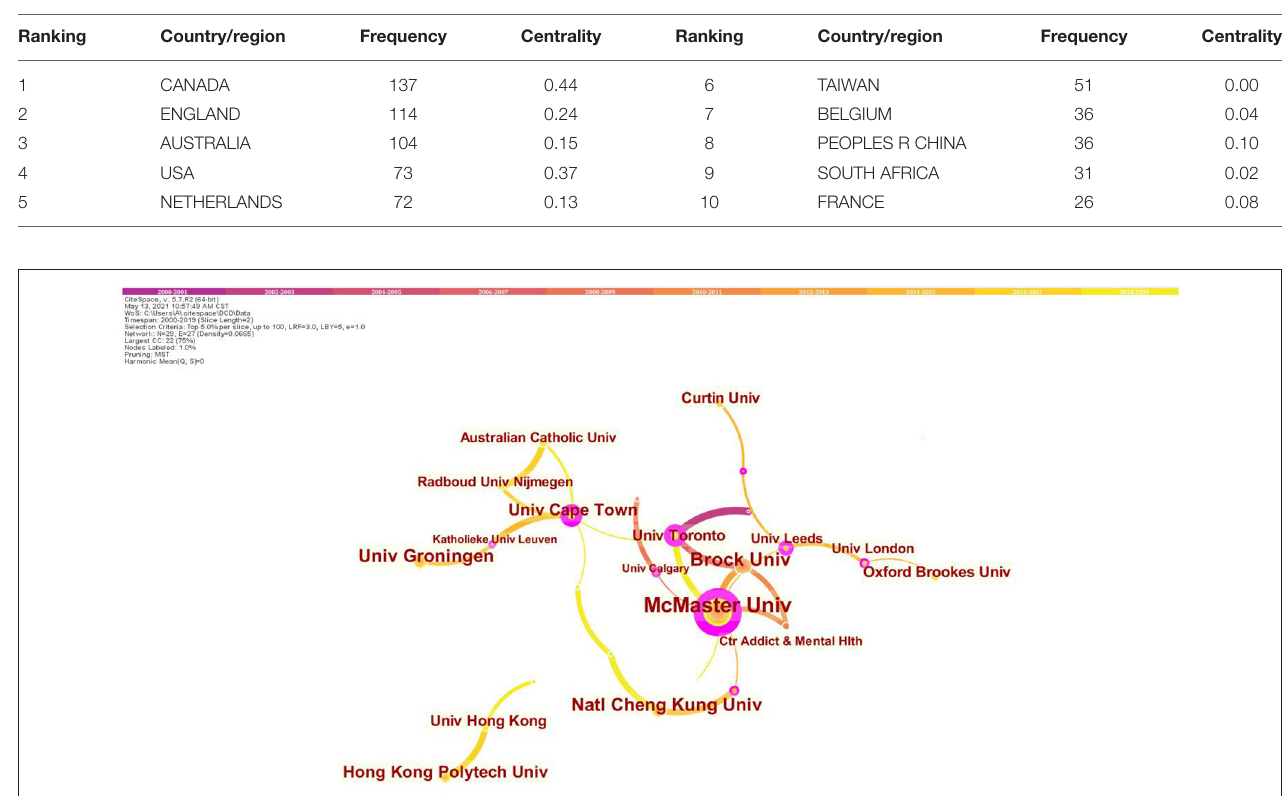
TABLE 1 | Top 10 prolific countries/regions in research of children with DCD, 2000–2019.